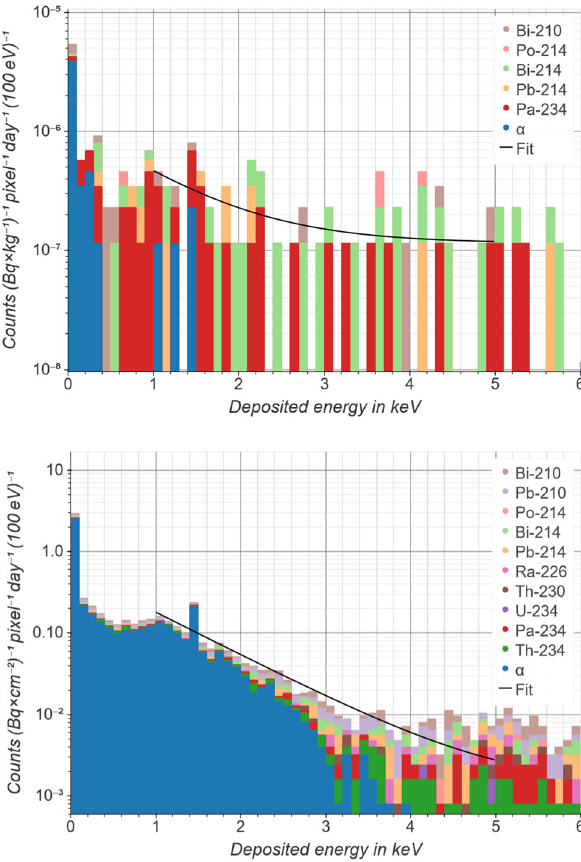
Fig. 11 Simulated spectrum of deposited energies in the MMC absorbers caused by a bulk-distributed 238 U and b surface-distributed 238 U in the circuit